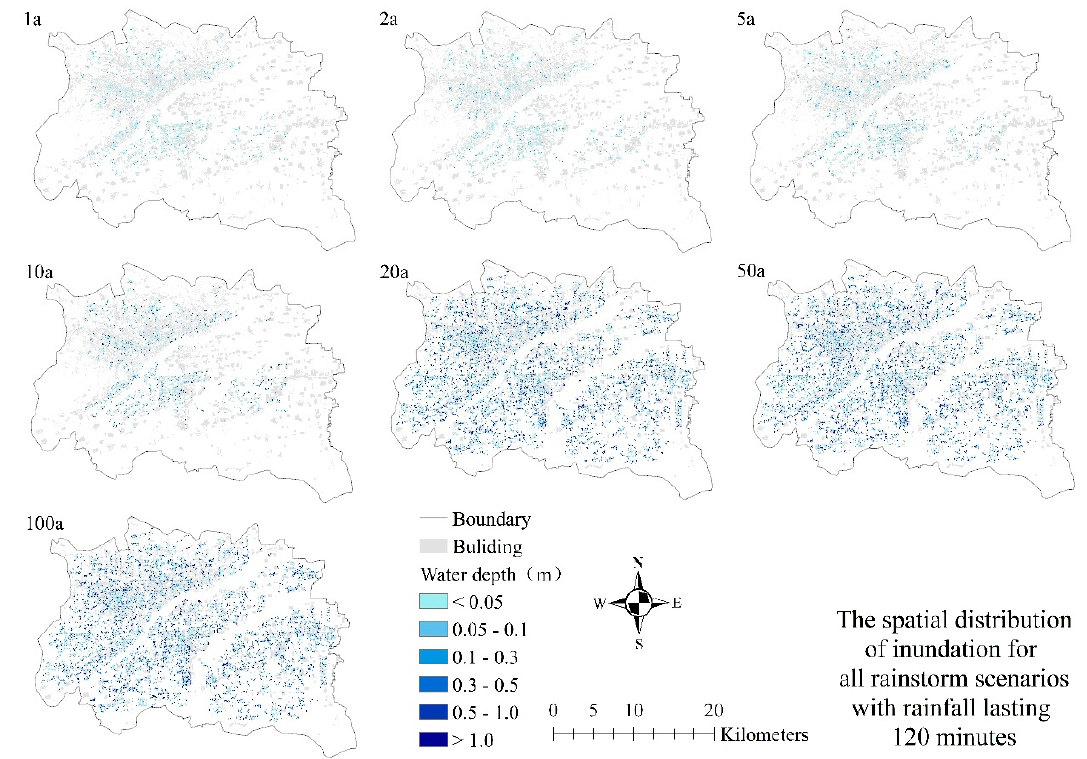
Figure 10. Spatial distributions of inundation for 120 min rainstorm scenarios.